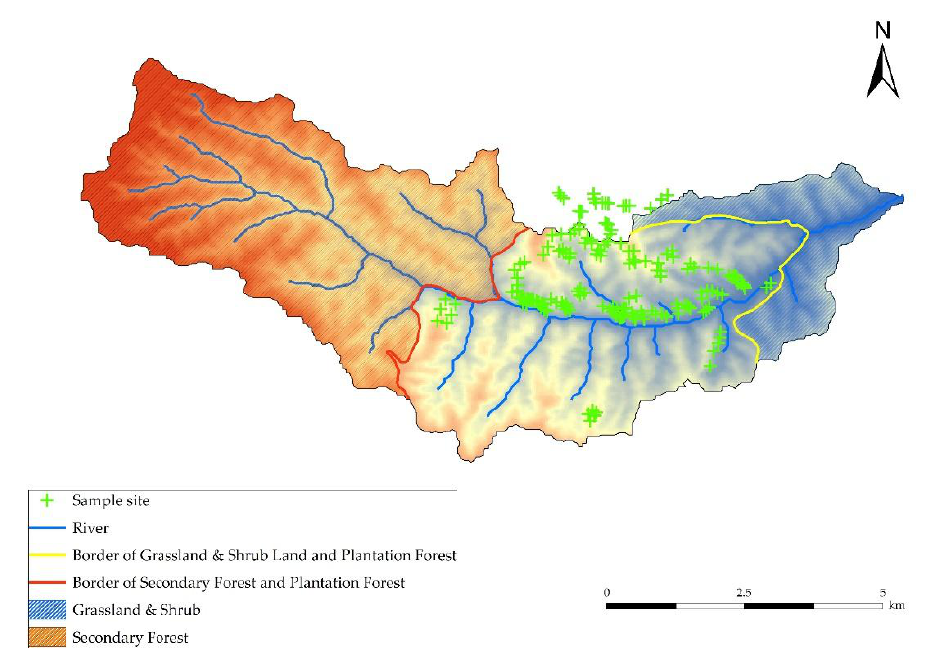
Figure 1. Distribution of standard plots.